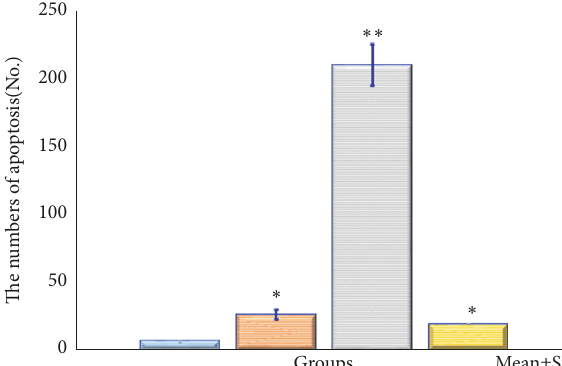
Figure 13: The number of cells undergoing apoptosis after elec- trochemical therapy in 12hr after treatment. The distribution of apoptosis of the tumor. Quantitation was performed as described in thetextandthedistributionofapoptoticbodiesexpressedinrelation to position on the tumor cells. Significantly different ∗ p < 0.05 , ∗∗ p < 0.01 , control vs . 10mA × 150sec, 10mA × 300sec, 10mA × 600sec. The results represent ± S.D. from 8 to 10